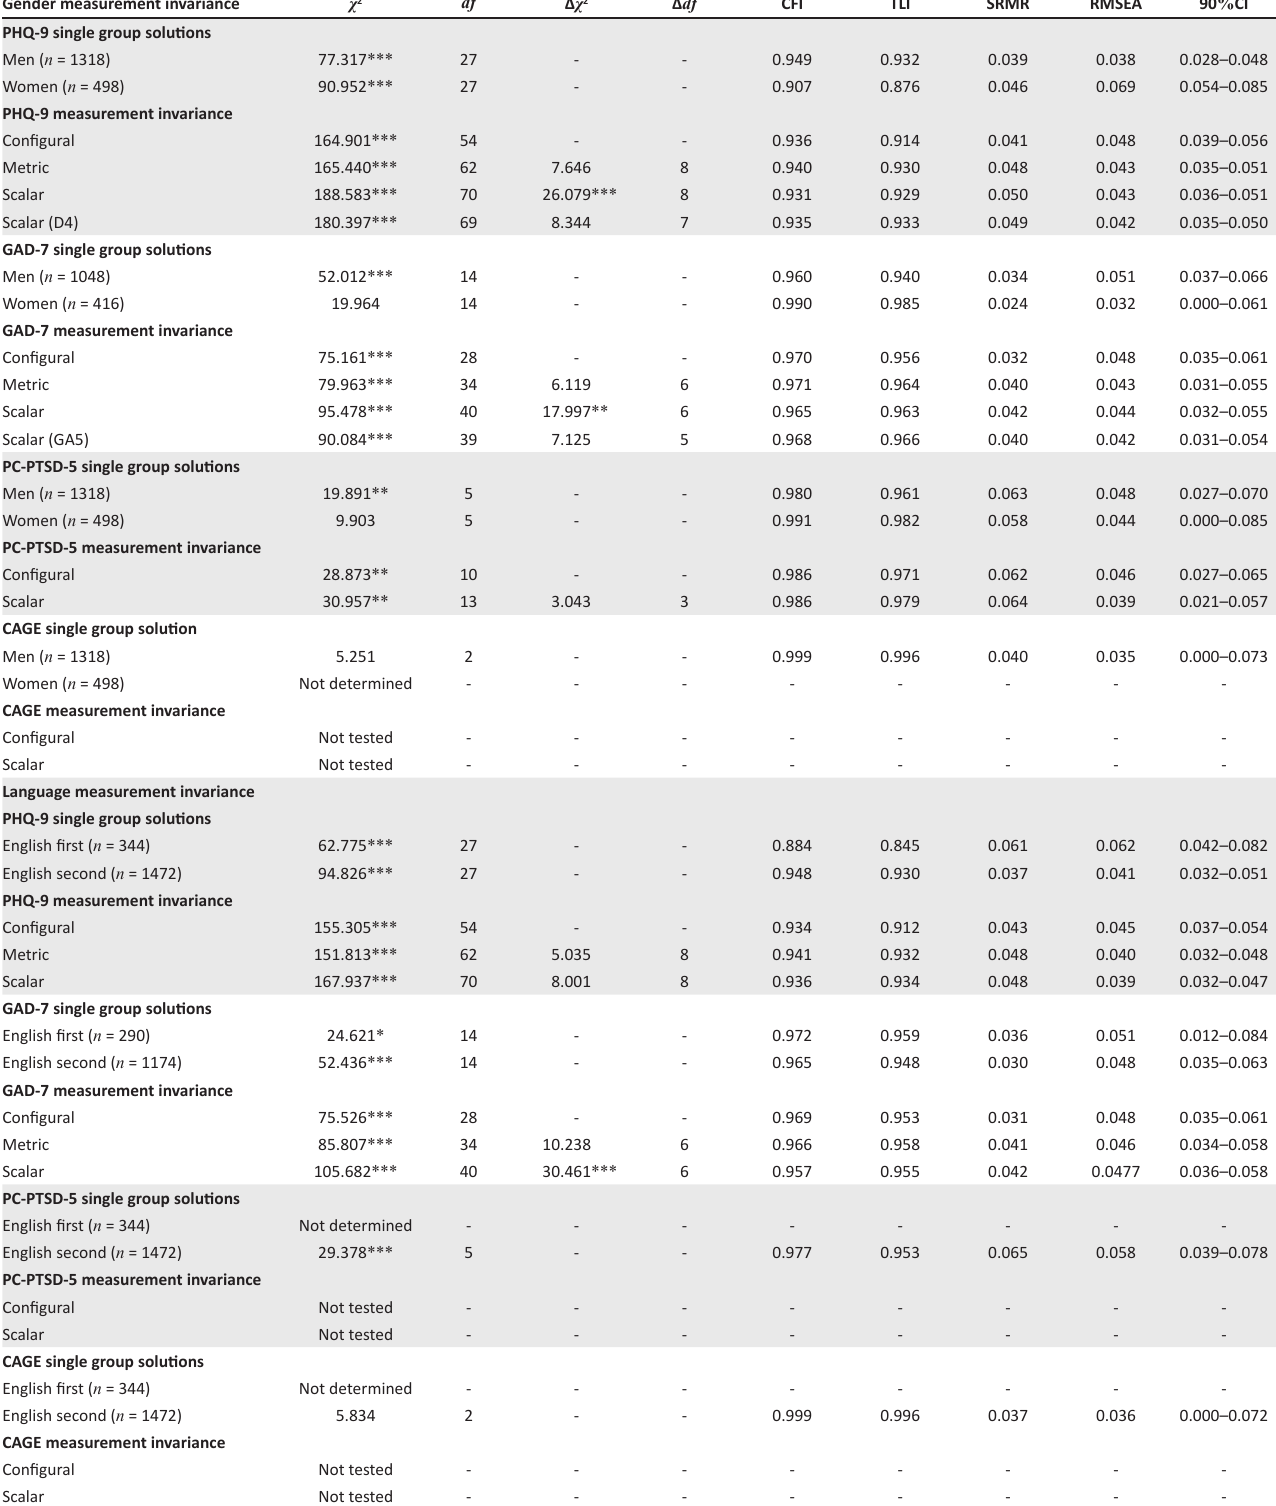
TABLE 4: Measurement invariance statistics for gender and language. Gender measurement